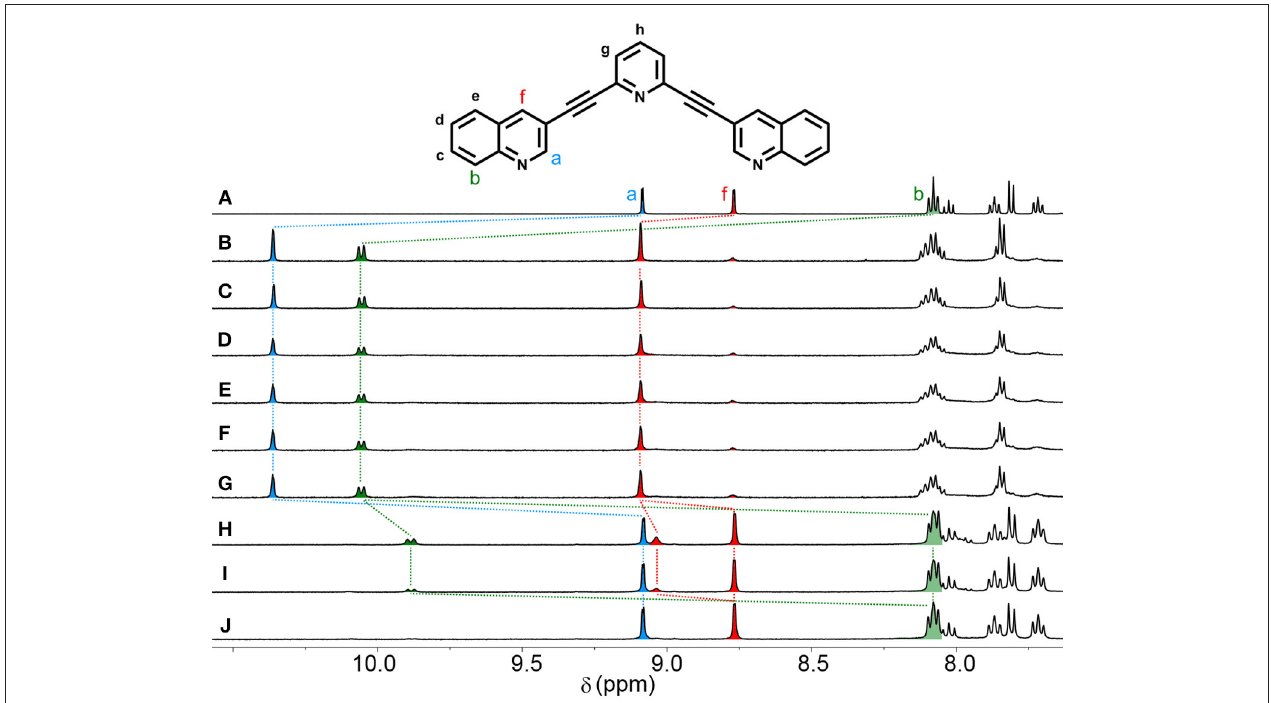
et al., 2011), A549 (lung cancer) and non-cancerous primary cells: adult human dermal fibroblasts (HDFa) ( Table 1